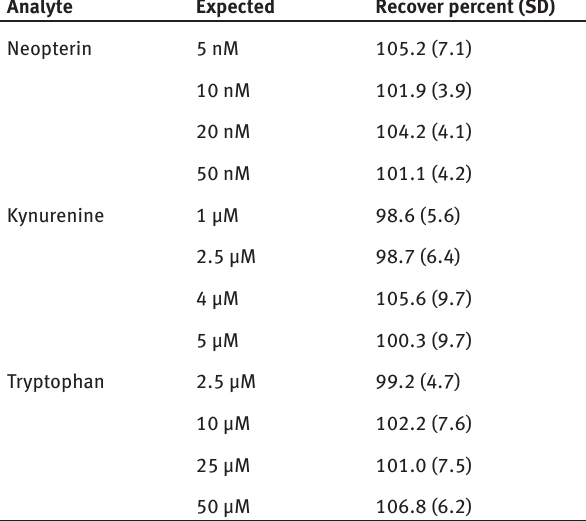
Table 1: Percent recoveries were measured by addition of neopterin, kynurenine and tryptophan (separately) into plasma samples and subtracting the unadulterated concentration. All compounds show a high level of recovery. Data is described as recovered percent of added compound with SD from quadruplicate